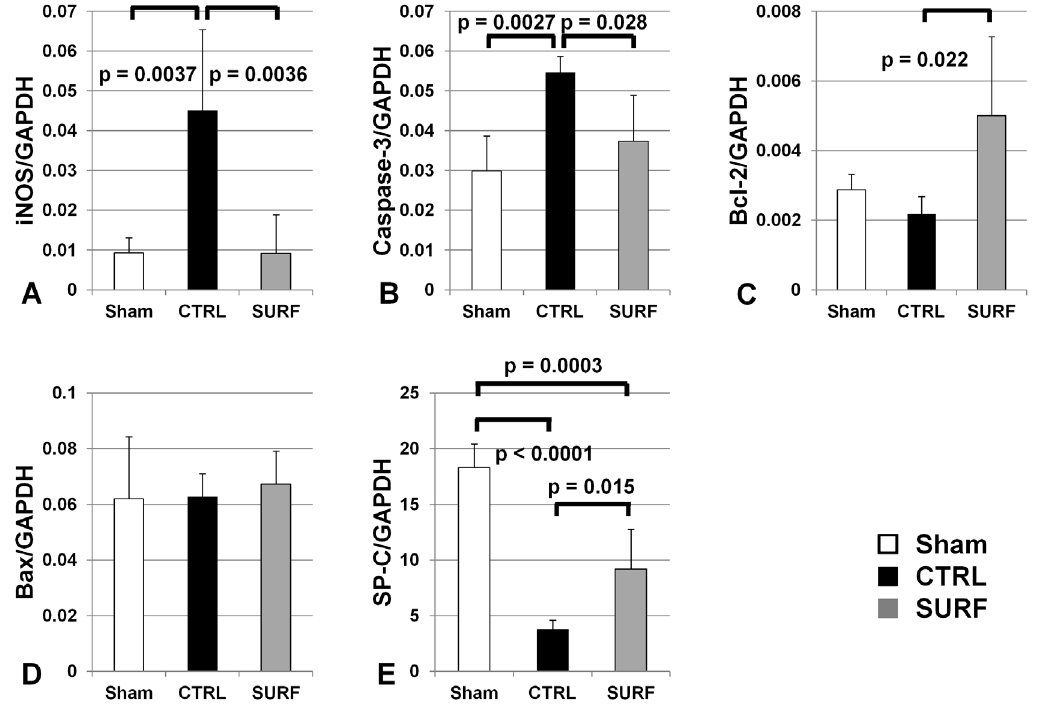
Figure 3. mRNA expression of cytokines after reperfusion. (A) iNOS mRNA levels. (B) Caspase-3 mRNA levels. (C) Bcl-2 mRNA levels. (D) Bax mRNA levels. (E) SP-C mRNA levels. All values are expressed as the mean 6 SD.